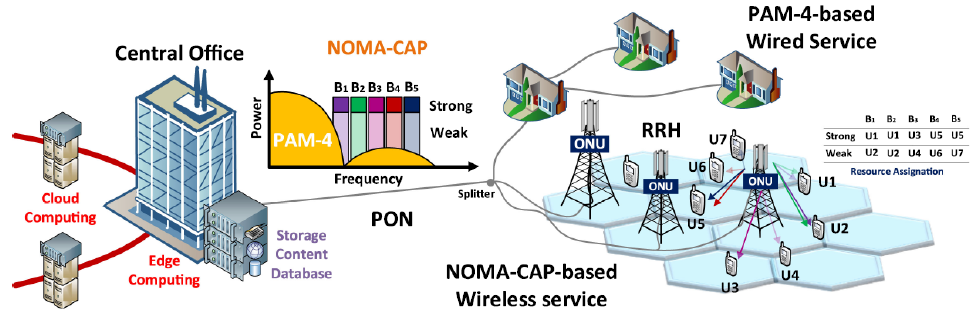
Figure 5. Conceptual diagram of a converged B5G fronthaul and PON architecture.